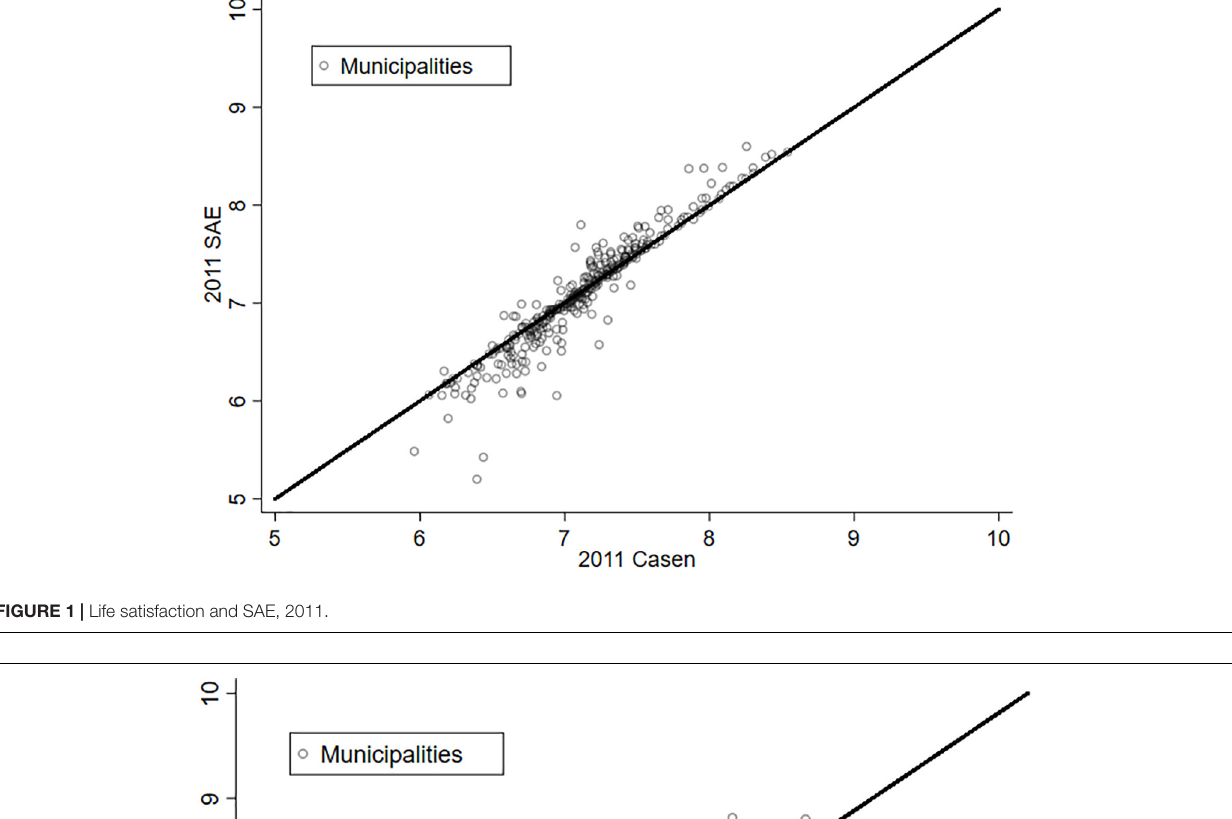
FIGURE 1 | Life satisfaction and SAE, 2011.